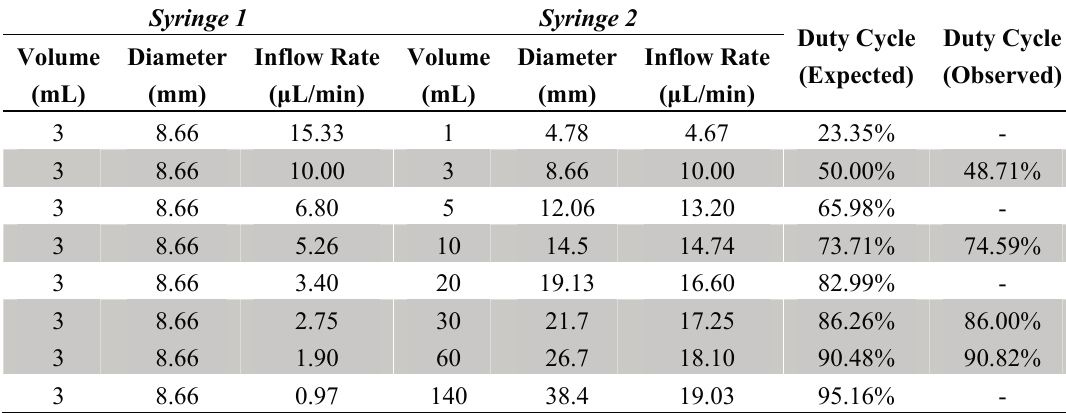
Table 1. Different syringe pairings on a single syringe pump enables different duty cycles to be achieved, while maintaining a constant total volumetric inflow rate of 20 μ